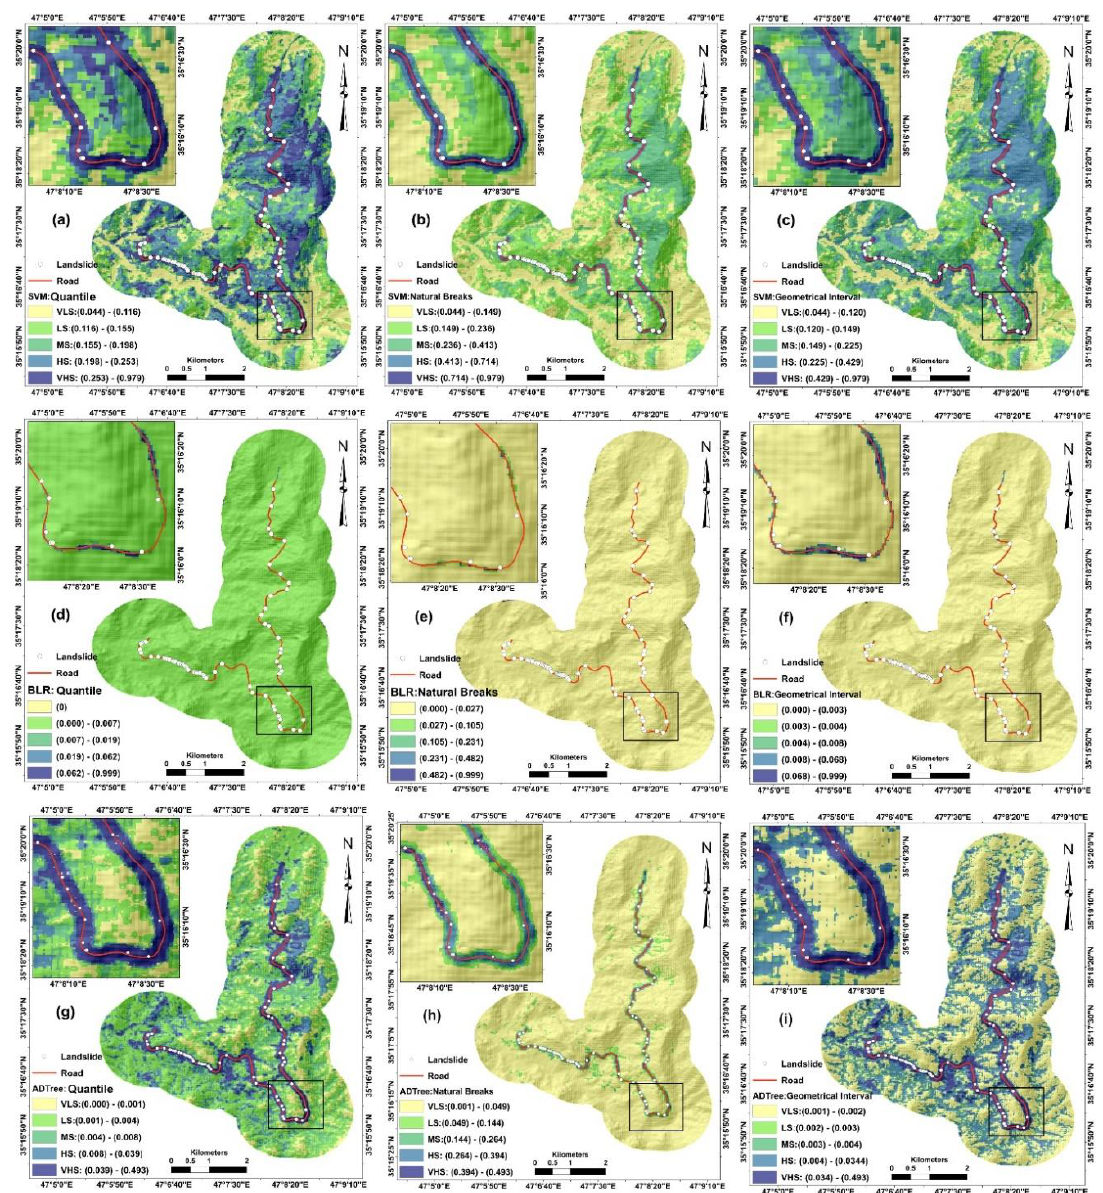
Figure 6. Landslide susceptibility maps generated by ( a ) SVM with the quantile method, ( b ) SVM with the natural break method, ( c ) SVM classified with the geometrical interval method, ( d ) BLR with the quantile method, ( e ) BLR with the natural break method, ( f ) BLR with the geometrical interval method, ( g ) ADTree with the quantile method, ( h ) ADTree with the natural break method, and ( i ) ADTree with the geometrical interval method.